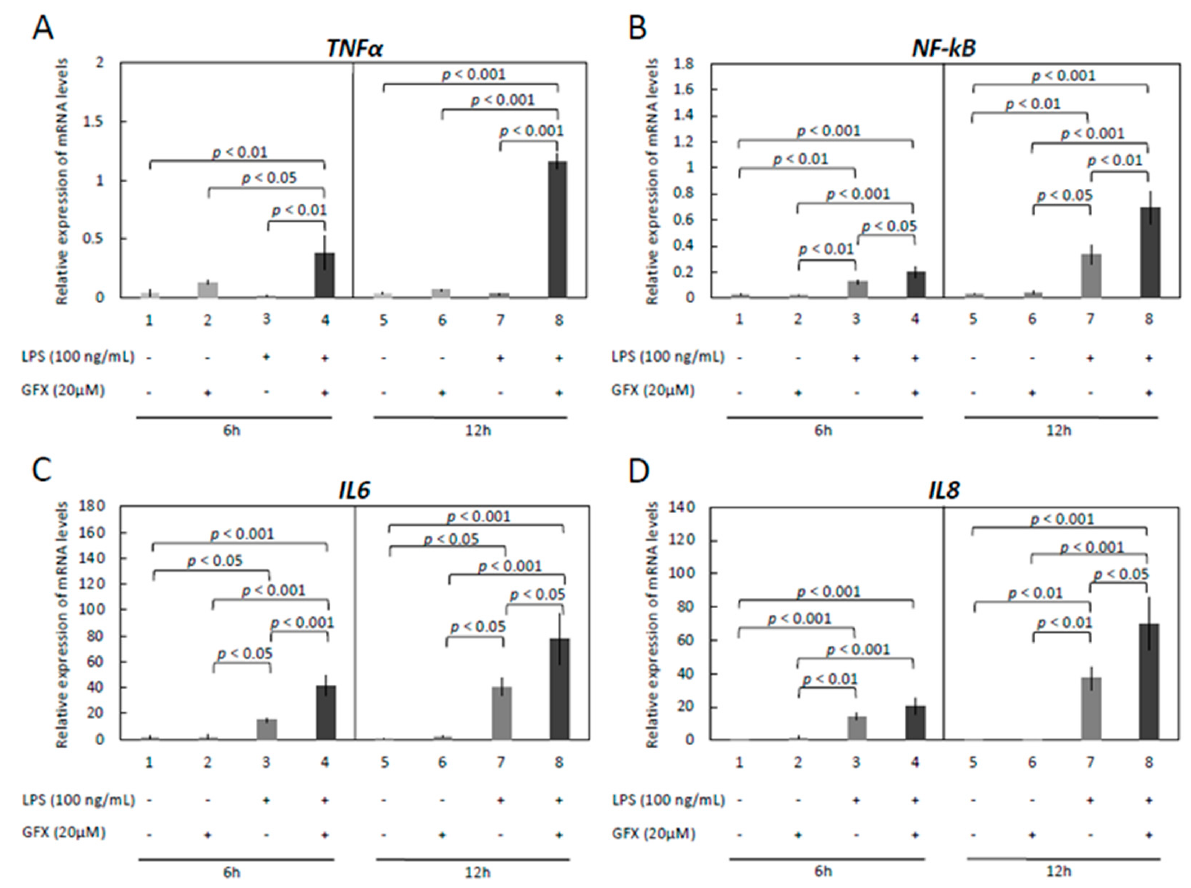
Figure 6. Effects of LPS treatment and inhibition of PKC (GF-109203X) activity on expression of TNF α , NF-kB , IL6 and IL8 in immortalized OLENDO cells. Expression of TNF α ( A ), NF-kB ( B ), IL6 ( C ), and IL8 ( D ) as determined by real-time (TaqMan) PCR. Inhibition of PKC (GF-109203X; GFX) activity was performed as described in the Materials and Methods. A parametric one-way ANOVA was applied followed by the Tukey–Kramer multiple comparisons post-test. All numerical data are presented as the means ± S.D. p -values < 0.05 were considered significant and are